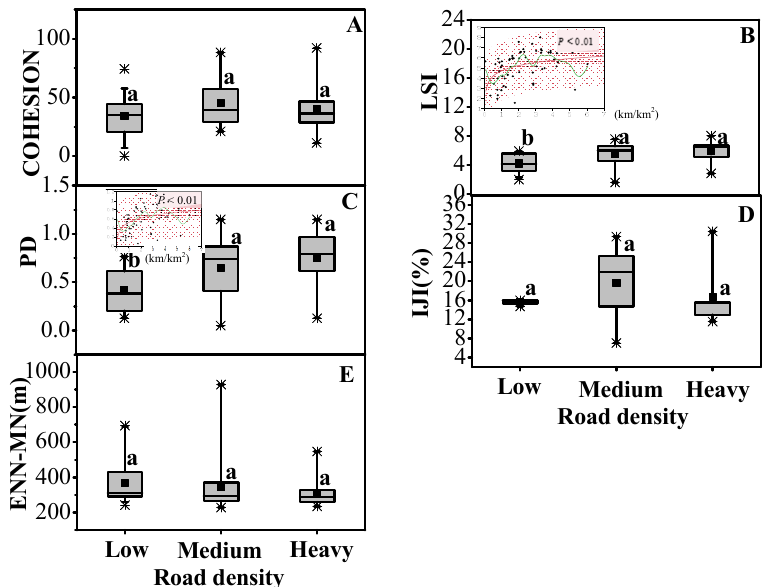
Figure 4. Urban forest landscape aggregation changes from low to heavy road density regions. ( A ) patch cohesion index (COHESION), ( B ) landscape shape index (LSI), ( C ) patch density (PD), ( D ) interspersion and juxtaposition index (IJI), and ( E ) mean Euclidian nearest neighbor distance (ENN-MN). The boxplots show the arithmetic mean (black square), median (black line in the box), inter-quartile range (25%–75% at the box upper and lower edge), and the normal value range (the whisker). The mean values sharing different letters are significantly different ( p < 0.05), and different letters at different RD regions are significantly different in their arithmetic means ( p < 0.05). The figure insets depict significant regression lines from the raw data. The red line is the regression line, and the green lines represent the moving mean value. The dual-shaded shadows represent the best-fitting and predicted interval